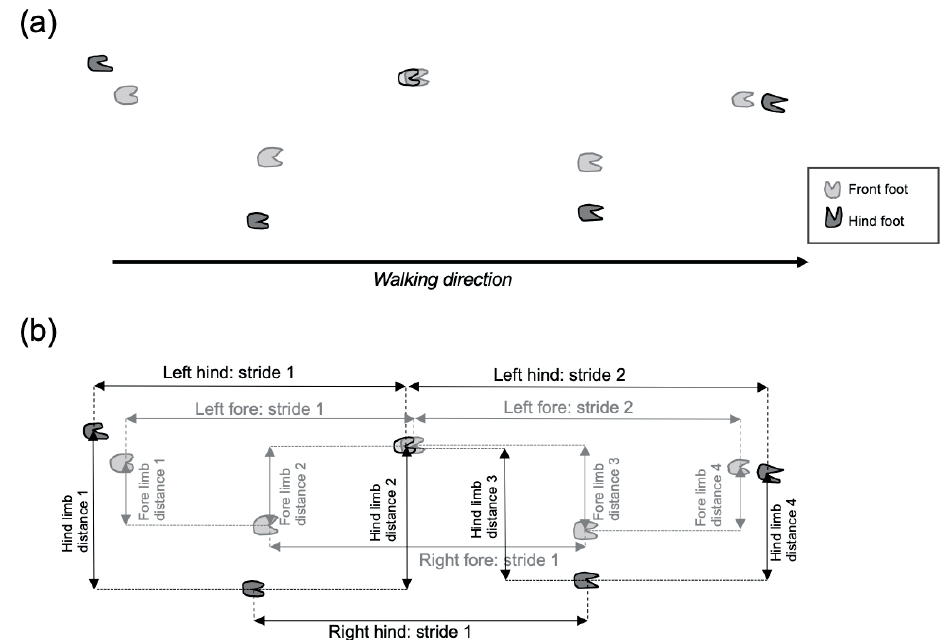
Figure 1. Manual acquisition, analysis, and assessment of gait. Feet are painted in two different colours to differentiate between front and hind limbs (light and dark grey respectively) and animals are made to walk over approximate 5 m length of paper once habituated to the process. ( a ) Overlay of hoof prints from a photograph and ( b ) measurements of stride length (left and right), forelimb and hindlimb